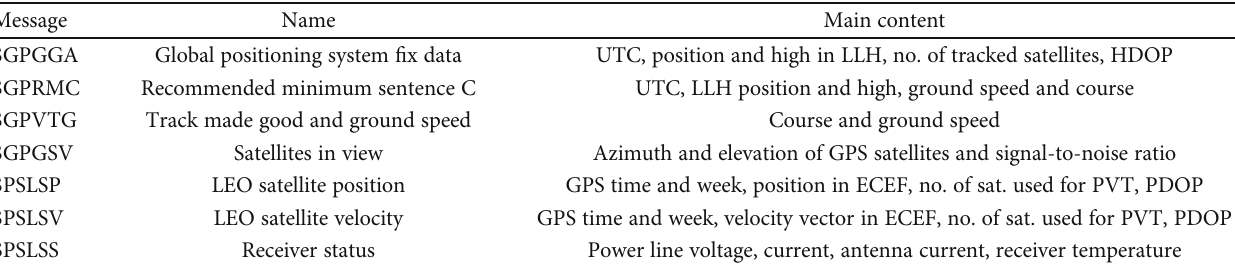
Table 2: piNAV output messages.